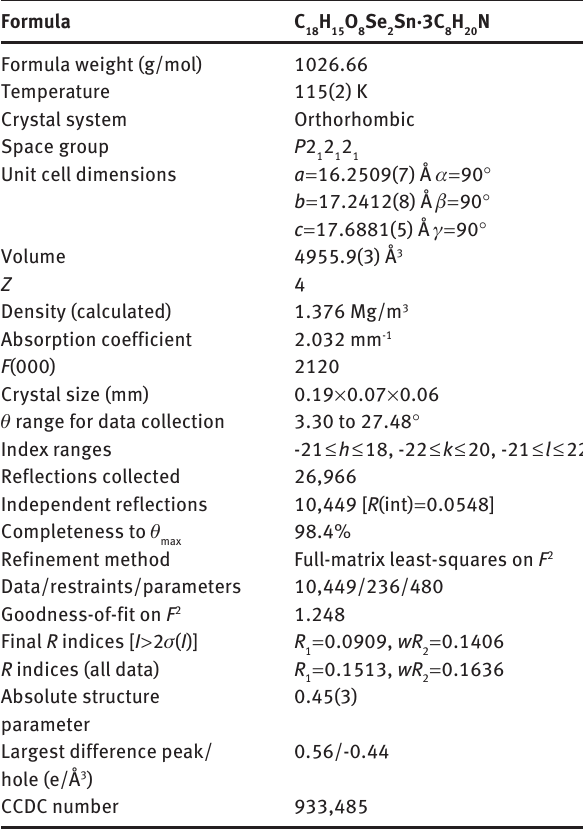
Table 1 Crystal data and structure refinement of compound 1 .